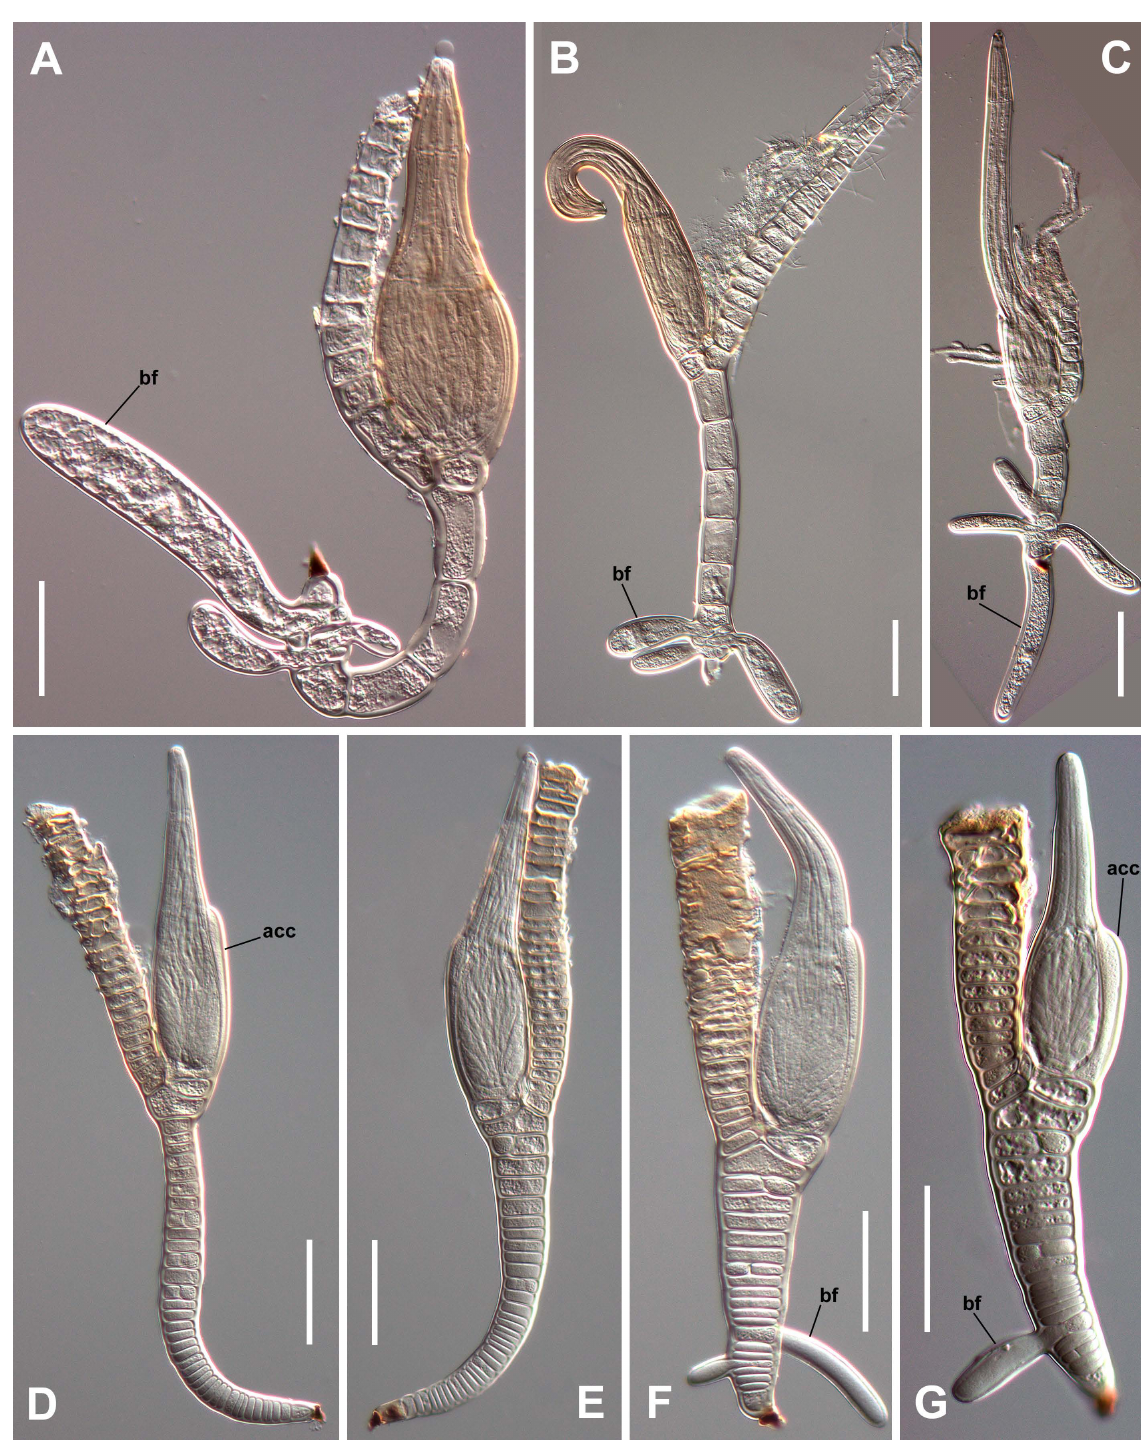
Fig. 7. Hydrophilomyces spp., mature thalli. A – B . H. coneglianensis Speg. Thallus from female (A) and from male hosts (B). – C . H. digitatus F.Picard. – D – E . H. gracilis T.Majewski. – F – G . H. hamatus T.Majewski. Abbreviations: acc = accessory cell; bf = buffer cells. Scale bars: 50 µm. Photographs from slides ZMUC C-F-122709 (A), ZMUC C-F-124088 (B), ZMUC C-F-124274 (C), ZMUC